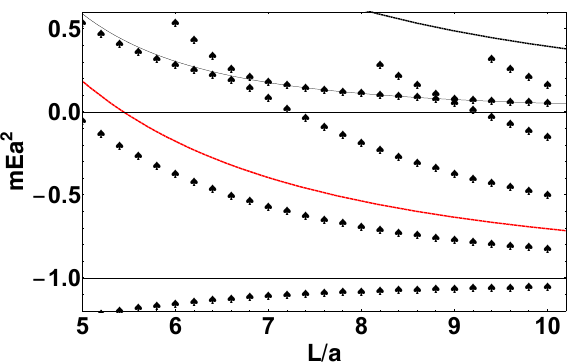
Figure 11: The 3-body lattice spectrum in A + old is located at − 1 . 0 while 3-body threshold at 0. Red dashed line indicates the spectrum for free state of a 2- body bound state and a spectator. Black dashed line is the free line for the 3 free particles. Black solid line is the theoretical calculation for the 3-body ground state.